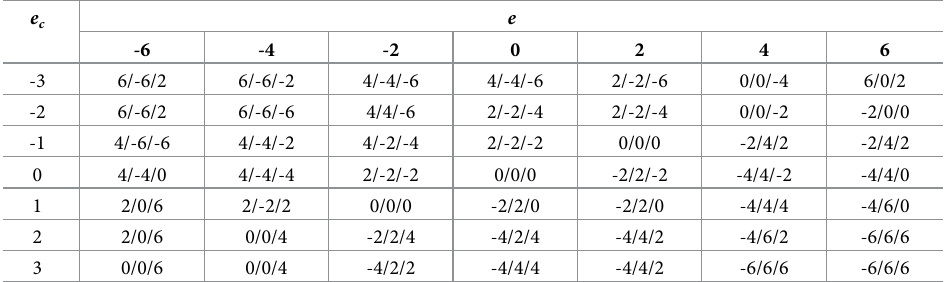
Table 4. Fuzzy control rules table of Δ K P Δ K I and Δ K D for unwinding